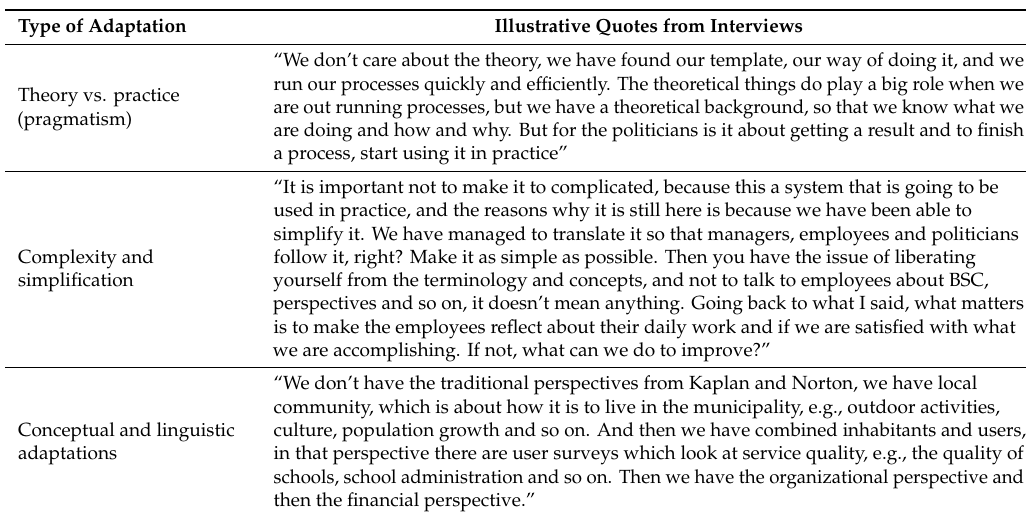
Table 21. Adaptations of the BSC